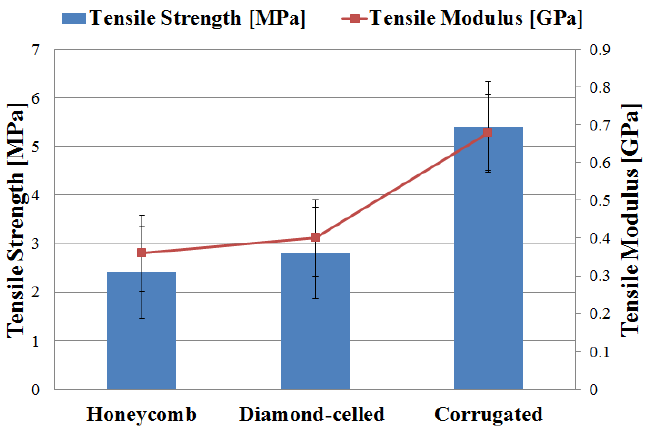
Figure 13. The tensile strength/modulus of the specimens.